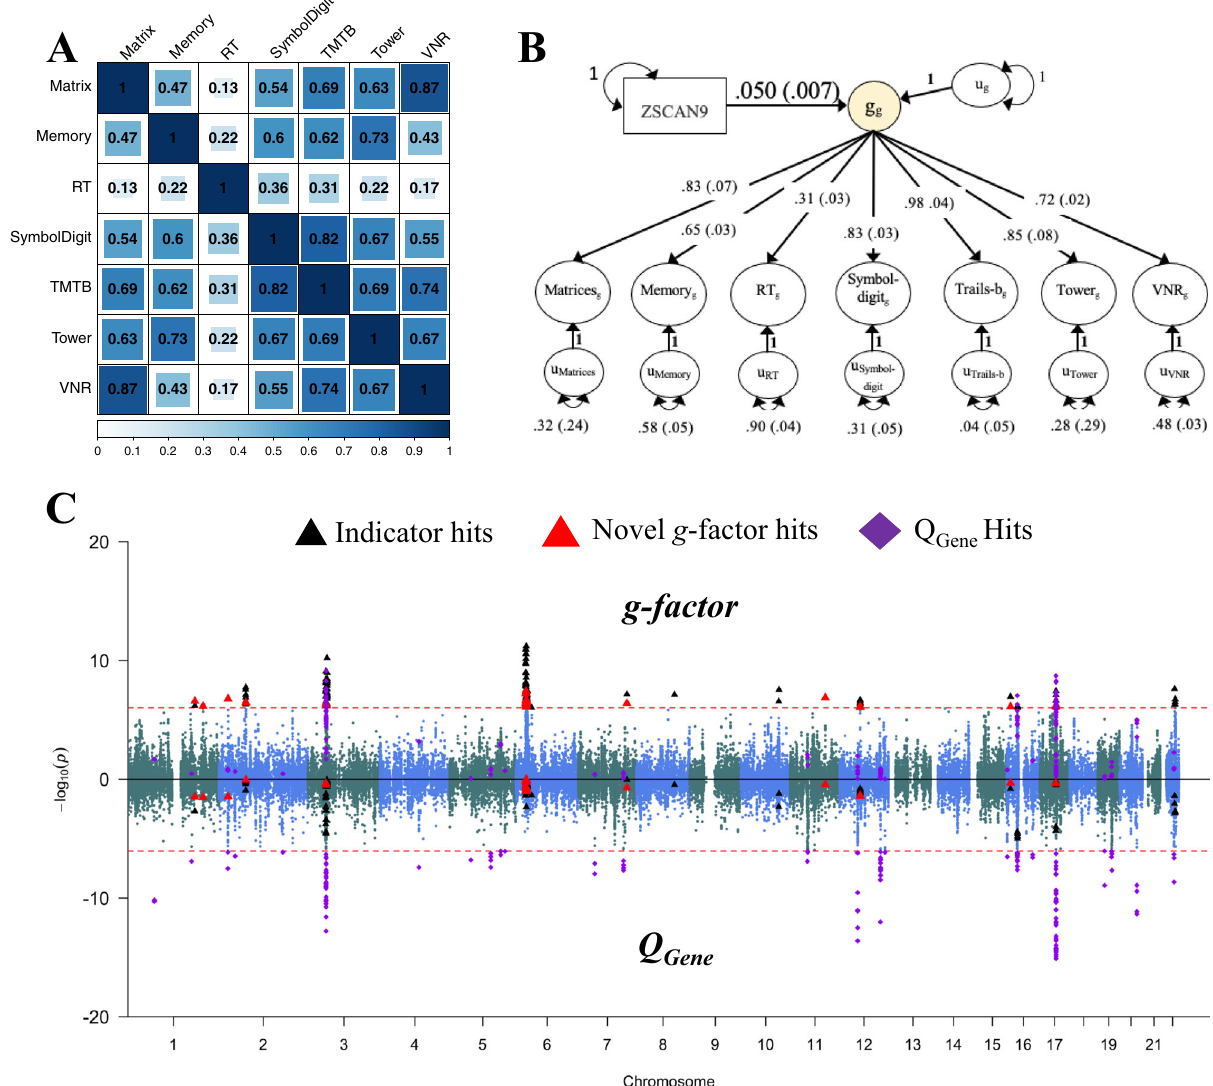
Fig.1 | g -factorT-SEM. Panel A depictsthegeneticcorrelationmatrixasestimated using LDSC for the seven, g -factor cognitive phenotypes. The size of the blue- colored square is scaled according to the size of the genetic correlation point estimate. Panel B depictstheresults from theinferred tissue-speci fi cexpressionof the top gene, ZSCAN9 in the cerebellum, predicting the g- factor estimated using T-SEM. Results are standardized with respect to the genetic variance in the seven cognitive traits, whereas the variance in the genetic g- factor is 1+ the variance explained by the individual gene (in this case: 1+0.05 2 =1.0025). Standard errors areshowninparentheses. Panel C depictstheMiamiplotfor g- factorT-SEMresults.